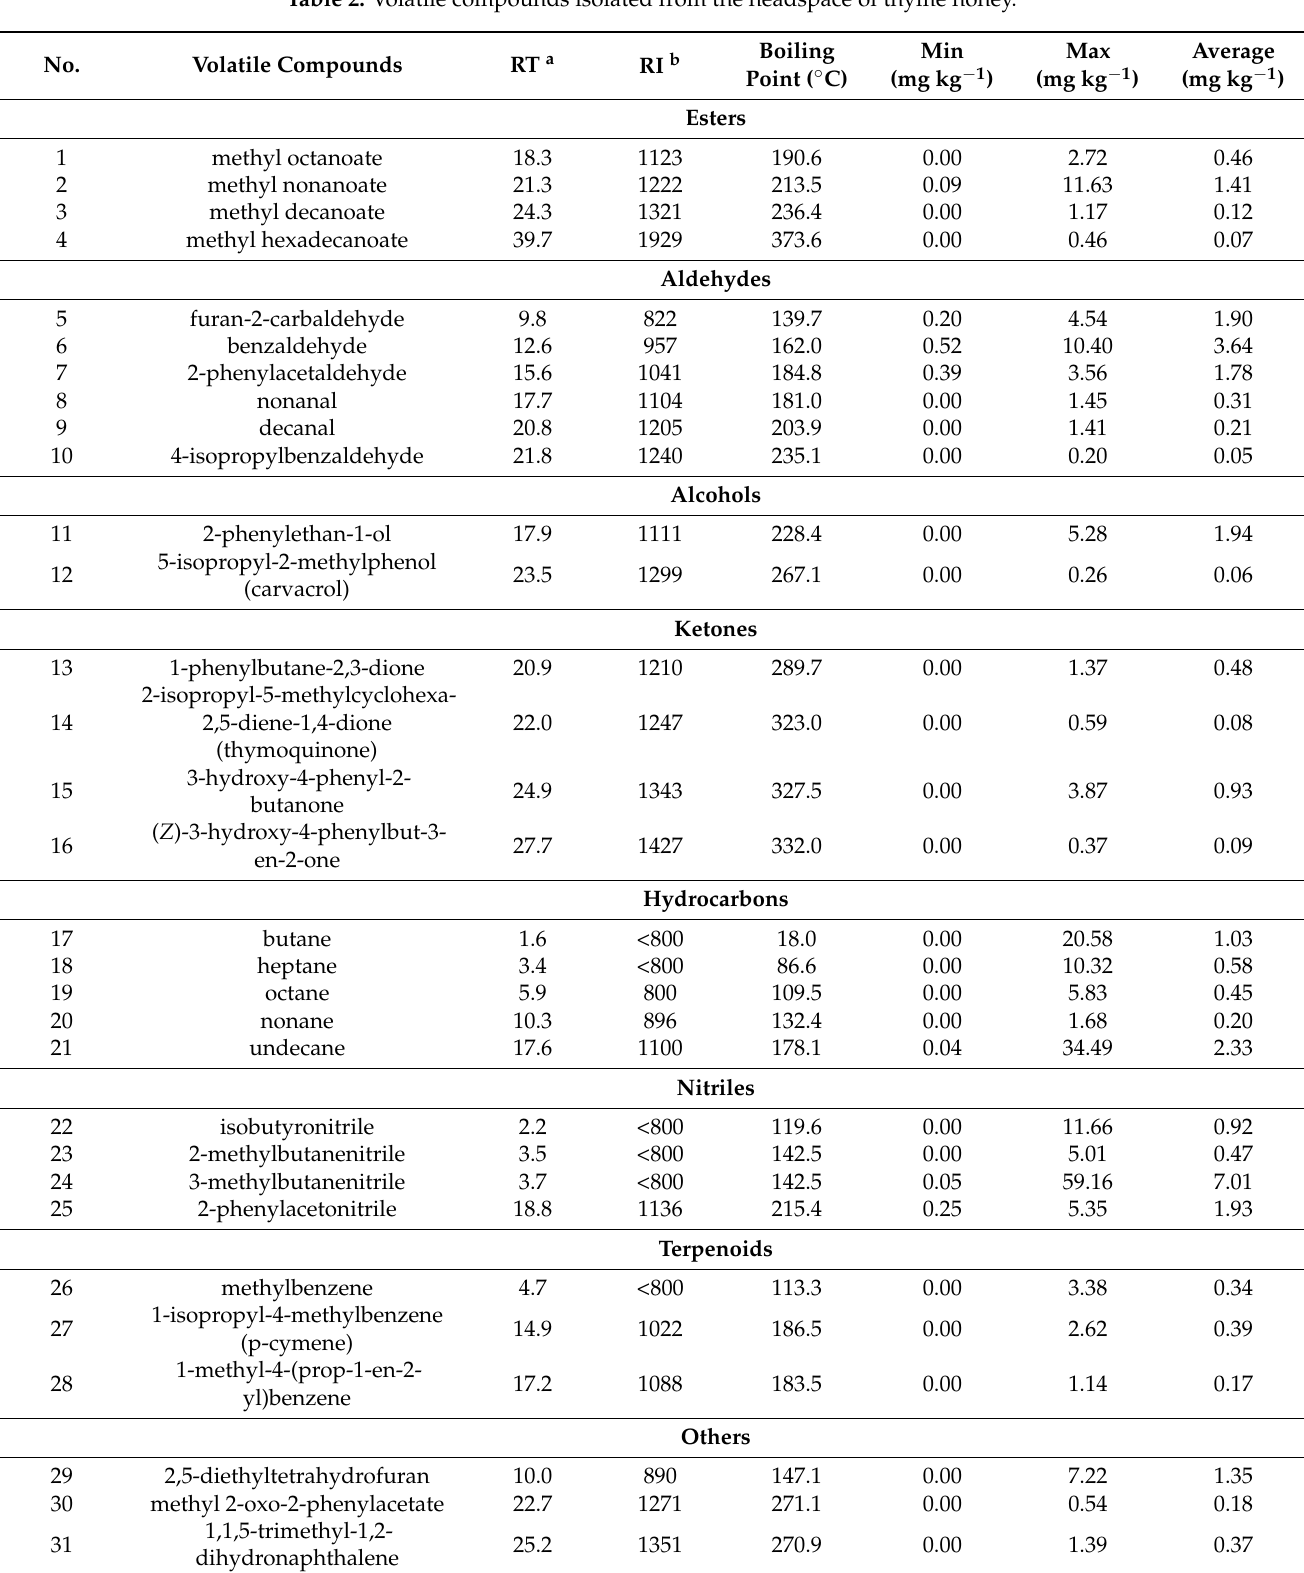
Table 2. Volatile compounds isolated from the headspace of thyme